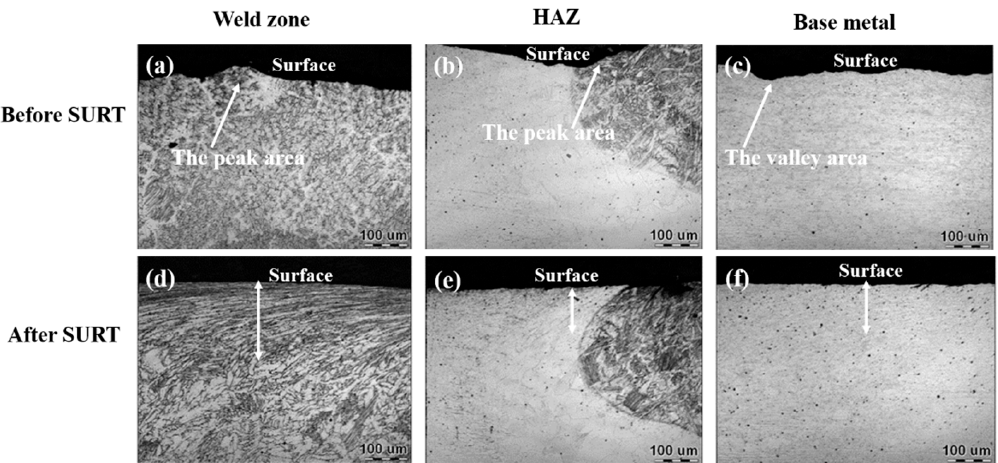
Figure 4. Surface microstructure of T4003 ferritic stainless steel welded joint before and after surface ultrasonic rolling. ( a – c ) Surface morphology before surface ultrasonic rolling. ( d – f ) Surface morphology after surface ultrasonic rolling. ( a , d ) Weld zone. ( b , e ) HAZ. ( c , f ) Base metal.